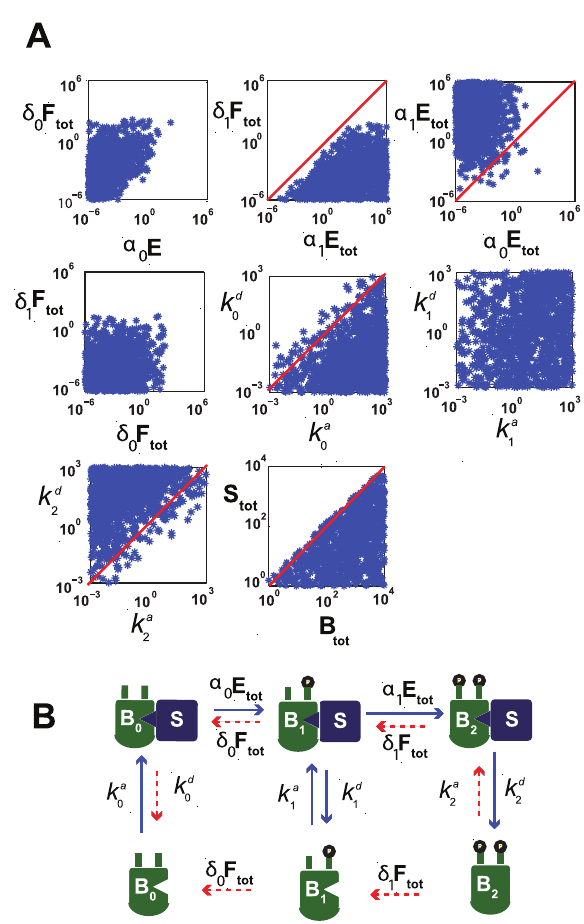
Figure 3. Kinetic constraints for multistability with linear (de)phosphorylation rates with scaffold binding (LR-S) for two phosphorylation sites (n=2). A) After each randomization of all the parameters the system is tested for bistability. If the test is positive one star is placed on each of the graphs in order to describe the parameter set. B) Cartoon depiction of the specific kinetic behavior, based on the parameter selection plot in (A). The dashed red arrows represent weaker interactions as measured in (A).